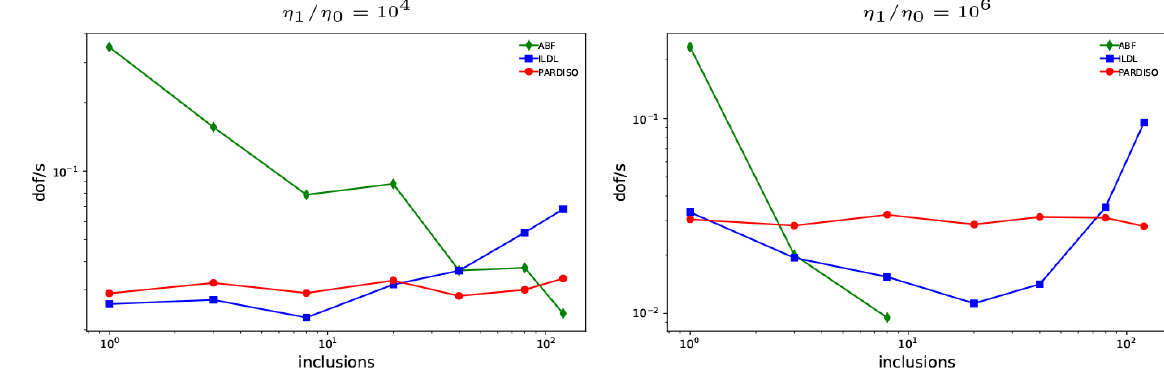
Figure 2. The effect of increasing the number of viscous inclusions on the effectiveness of solvers, for a 32 3 element simulation. Up to 140 non-overlapping inclusions of radius 0 . 05 are placed randomly in the unit cube. ILDL preconditioning becomes more competitive for more challenging structures, showing much greater robustness to viscosity structure than ABF solvers while maintaining a lower memory footprint than direct solution. Missing ABF data indicate that the solver failed to converge. Memory footprints are similar to those shown in Fig. 1; the direct solve (red) requires approximately 4 × as much memory as the ILDL-preconditioned solve.